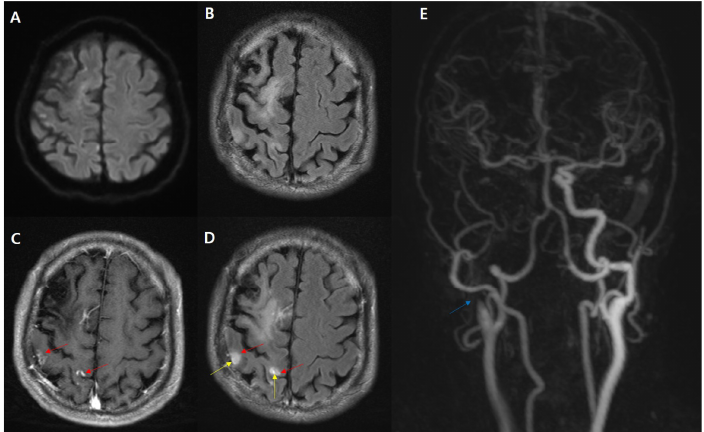
Figure 1. Typical HARM related to subacute infarction. A 65-year-old male presented with back pain and left side weakness after slipping in his house. DWI ( A ) with low signal intensity on the ADC map (not shown) showing a barely discernible hyperintense sign. Postcontrast T1WI ( C ) showing multiple nodular enhancement at the right parietal cortex (red arrow). A postcontrast FLAIR image ( D ) showing a linear enhancement along the adjacent right parietal sulci (yellow arrow), which is well-visualized as compared with the non-enhanced FLAIR ( B ) consistent with the HARM. Carotid TOF-MRA showing occlusion of the right proximal ICA (blue arrow, ( E )). Diagnostics 2021 , 11 , x FOR PEER REVIEW